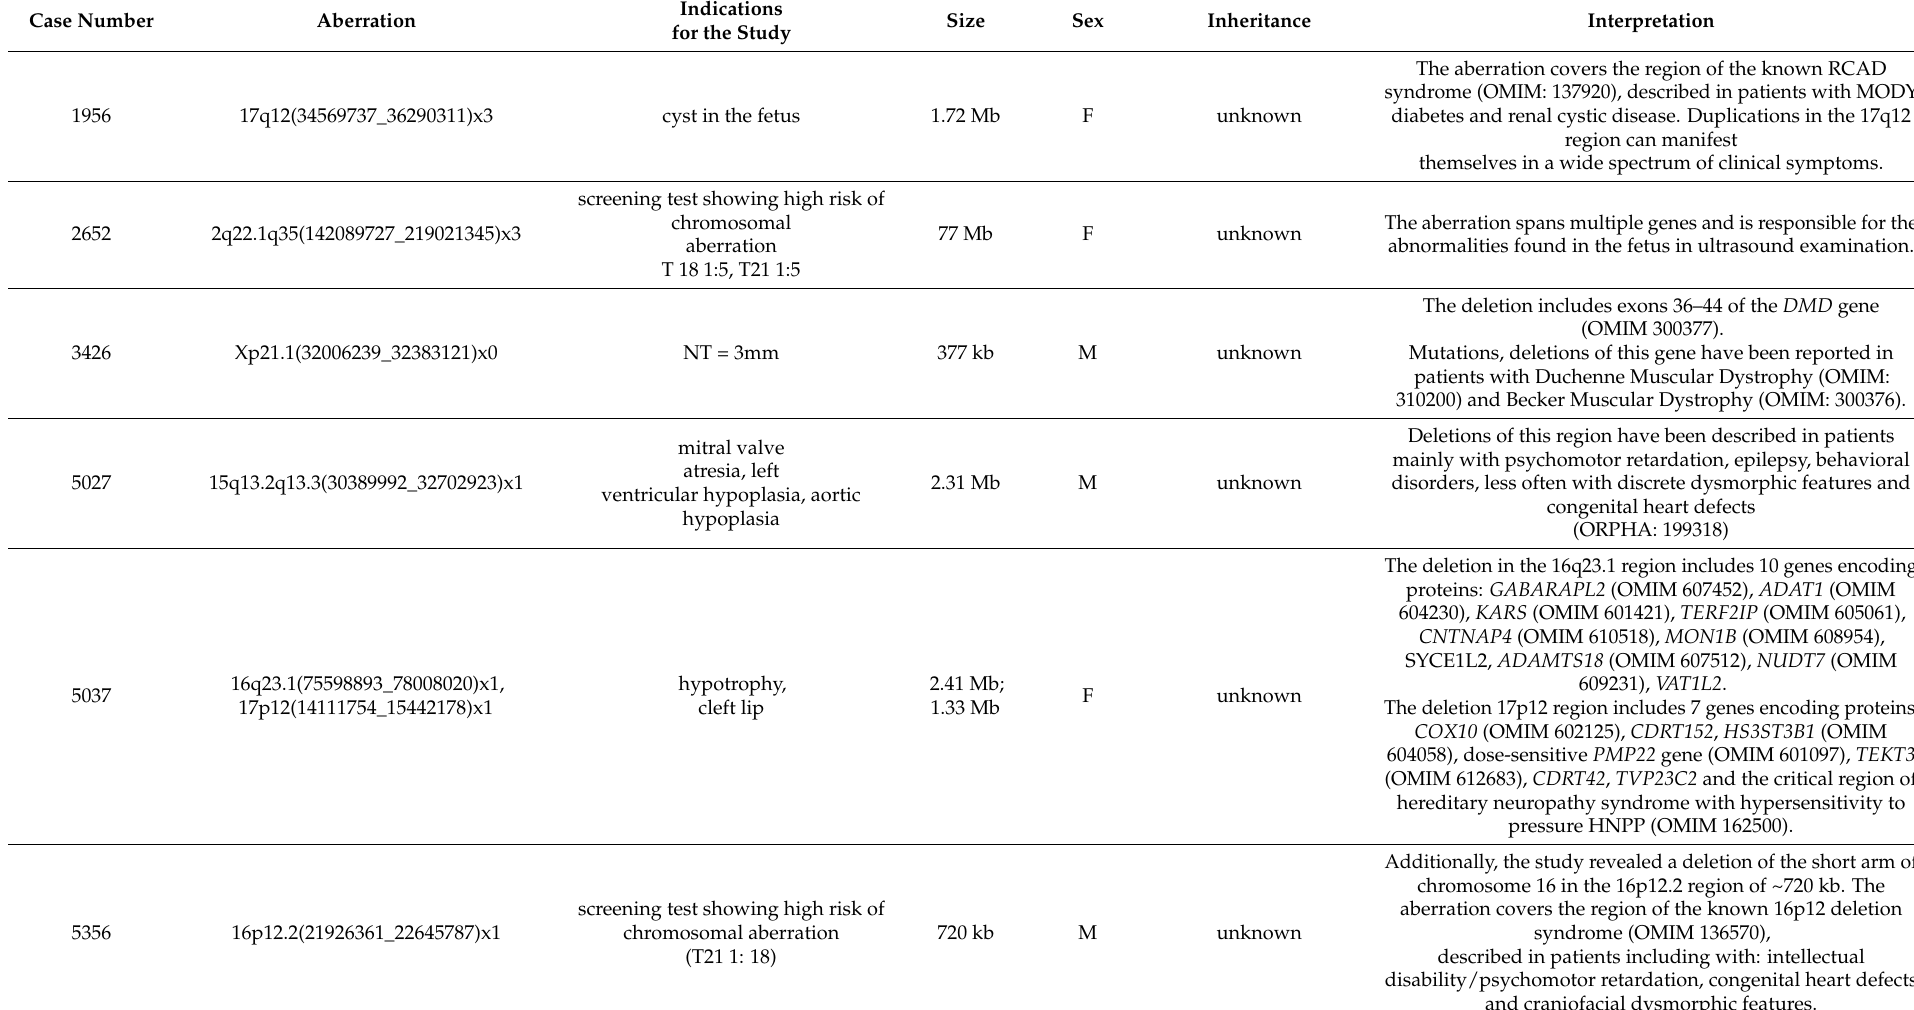
Table 6. Examples of interesting pathogenic CNVs which were correlated with the fetal